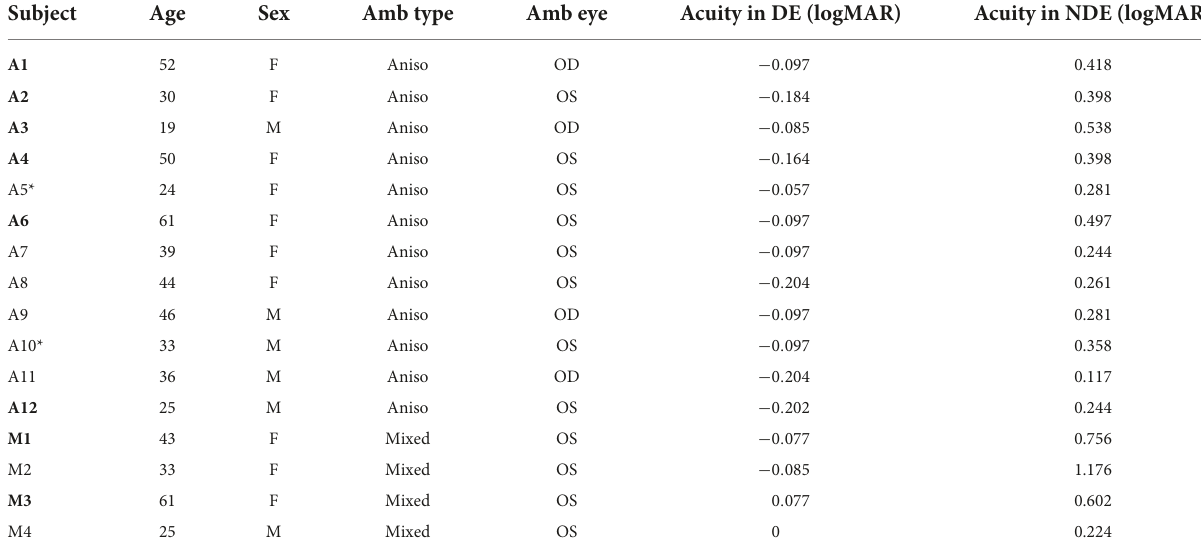
TABLE 1 Clinical data of persons with amblyopia